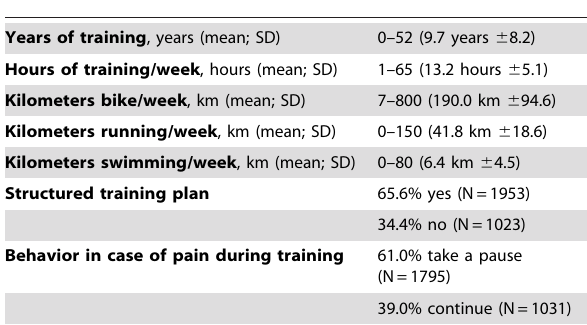
Table 5. Training